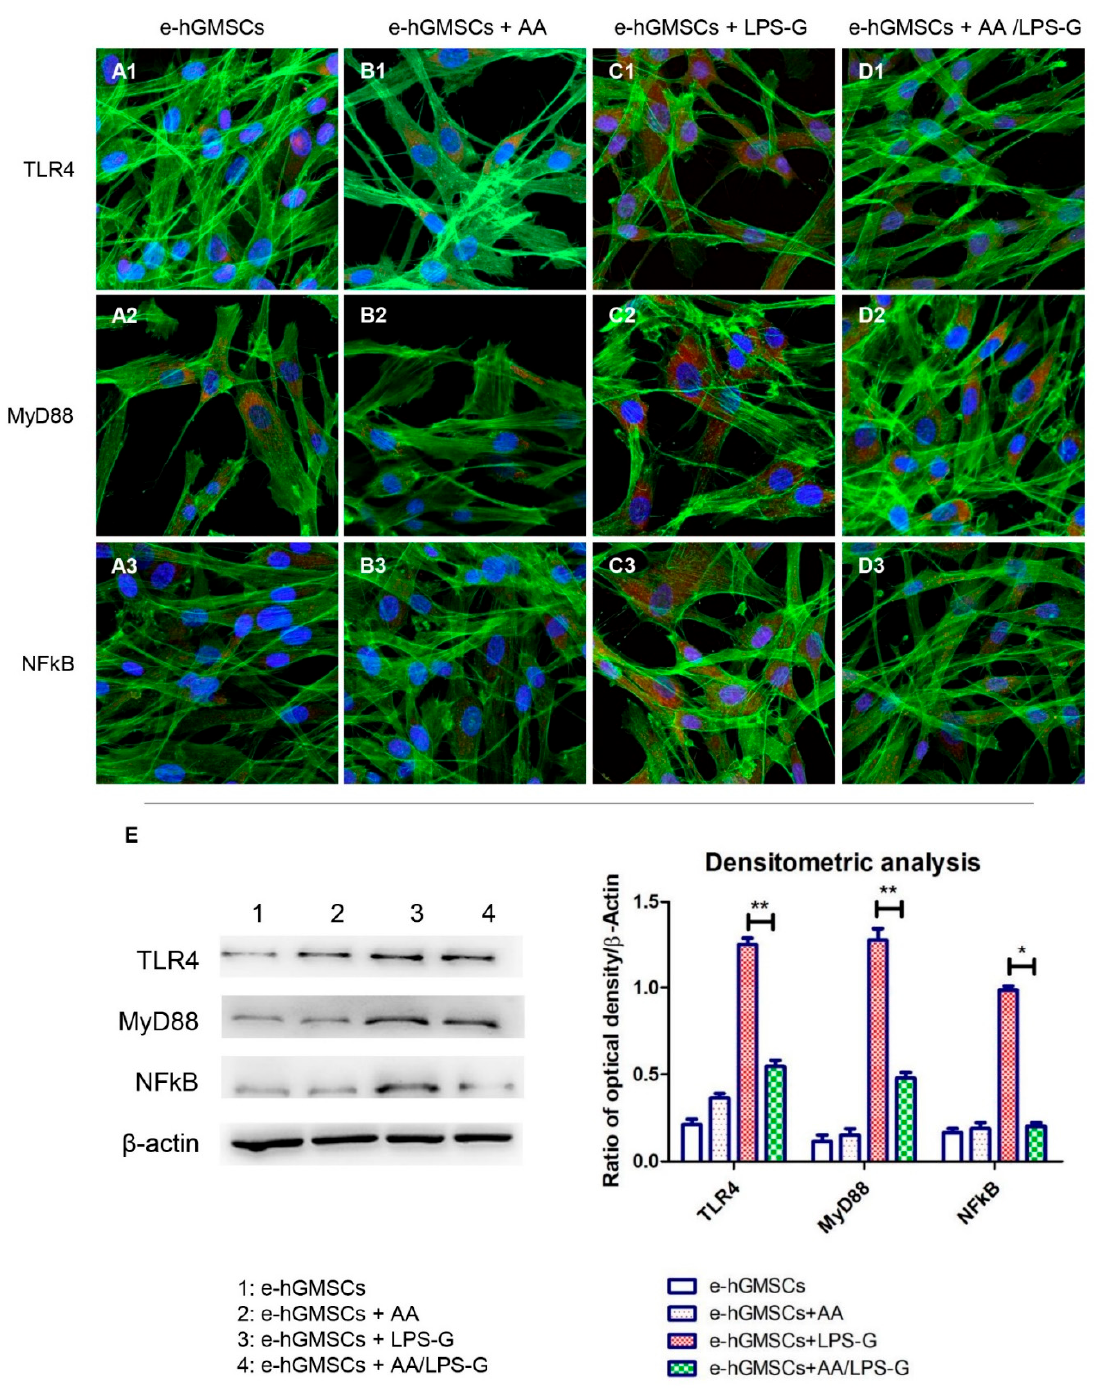
Figure 6. TLR4/MyD88/NF κ B signaling pathway and differences in protein levels in e-hGMSCs. Expression of TLR4, MYD88 and NF κ B, examined by confocal microscopy and Western blot experiments. ( A1 – D1 ) TLR4 expression in e-hGMSCs (CTRL), e-hGMSCs + AA, e-hGMSCs + LPS-G, e-hGMSCs + AA/LPS-G. ( A2 – D2 ) MyD88 expression in e-hGMSCs (CTRL), e-hGMSCs + AA, e-hGMSCs + LPS-G, e-hGMSCs + AA/LPS-G. ( A3 – D3 ) NF κ B expression in e-hGMSCs (CTRL), e-hGMSCs + AA, e-hGMSCs + LPS-G, e-hGMSCs + AA/LPS-G. ( E ) TLR4, MyD88 and NF κ B protein levels. β -actin was used as a loading control. Green fluorescence: cytoskeleton actin. Red fluorescence: TLR4, MYD88, NF κ B. Blue fluorescence: cell nuclei. Scale bar: 20 µ m. * p < 0.05; ** p < 0.01.